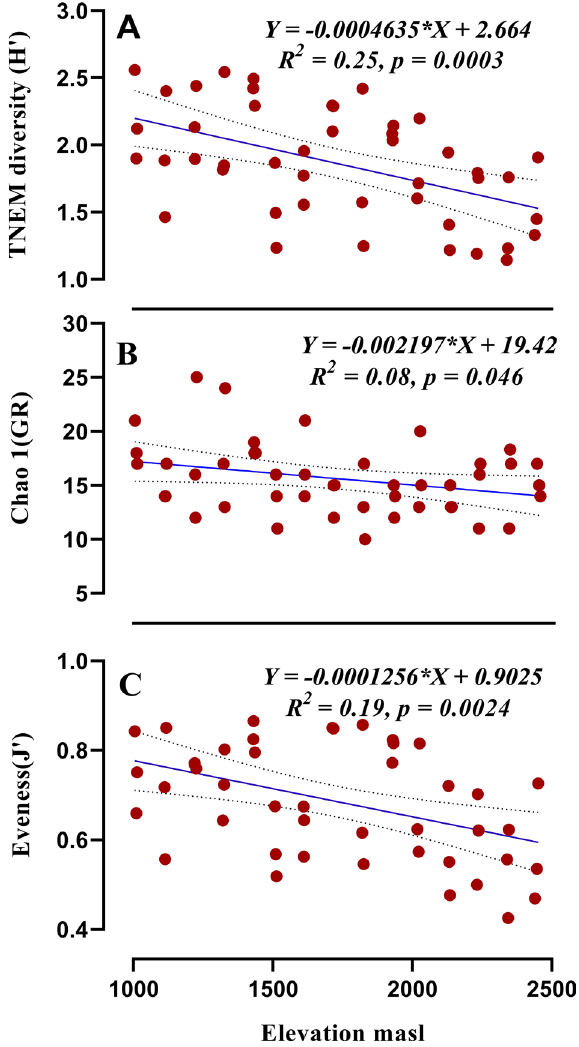
Figure 5. Relationship between elevation and total nematode diversity ( A ), generic richness ( B ) and evenness ( C ). Equation for Y , R 2 (coefficient of determination), p (significance) of linear regression, regression line and dotted lines of 95% of confidence interval are